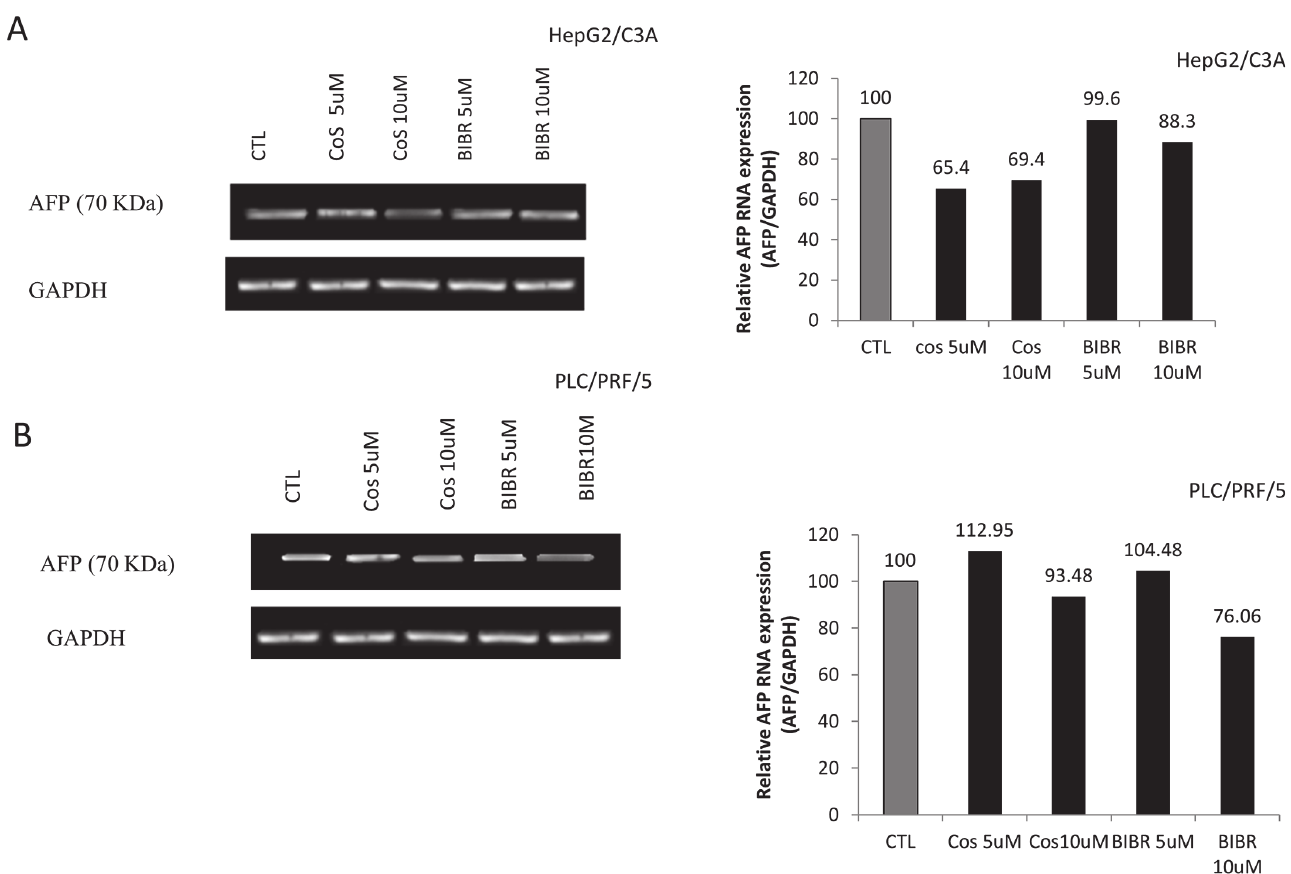
Fig 2. Effect of costunolide and BIBR1532 on APF mRNA expression by HepG2/C3A and PLC/PRF/5 cell lines. The cells were seeded in 75-cm 2 flasks in DMEM (1g/L). At 80% confluence, the cells were treated with costunolide (5, 10 or 50 μ M) or BIBR1532 (5, 10 or 50 μ M) for 48 h. The RNA from the cells was then extracted for RT-PCR. The amplified DNA was then run in a 2% agarose gel and visualized with SYBR Safe staining. The relative mRNA levels were obtained using the Gel Analyzer software. (A) Semi-quantitative reverse transcription- PCR analysis of AFP mRNA in HepG2/C3A cells after treatment with costunolide and BIBR1532 (5 and 10 μ M). Costunolide (10 μ M) and BIBR1532 (10 μ M) decreased the AFP mRNA levels by 30.6% and 11.7%, respectively. (B) Costunolide had no significant effect on AFP mRNA expression in PLC/PRF/5 cells, whereas BIBR1532 (10 μ M) decreased the AFP mRNA level by 23.94%. Each experiment was repeated at least three different